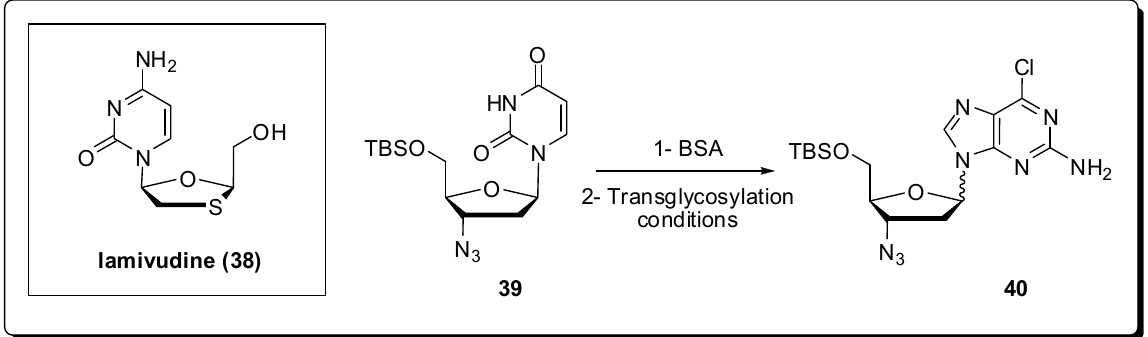
Figure 12. Lamivudine chemical structure and the reaction used for the optimization of the transglycosylation reaction with 3-azido